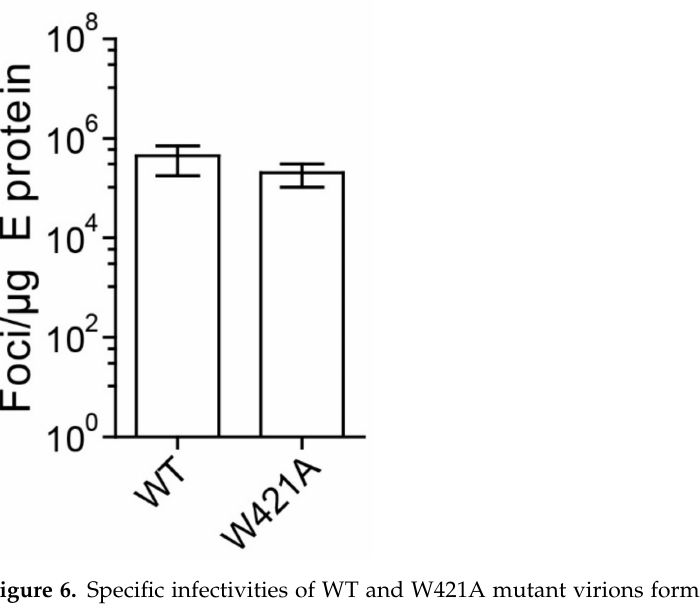
Figure 6. Specific infectivities of WT and W421A mutant virions form sucrose density gradients. Infectivities of virus peak fractions were determined in four independent focus assays. The infectivi- ties are expressed as number of focus forming units (FFU) per µ g E protein. Error bars represent the standard errors of the means (SEM). No significant difference to WT was observed ( t